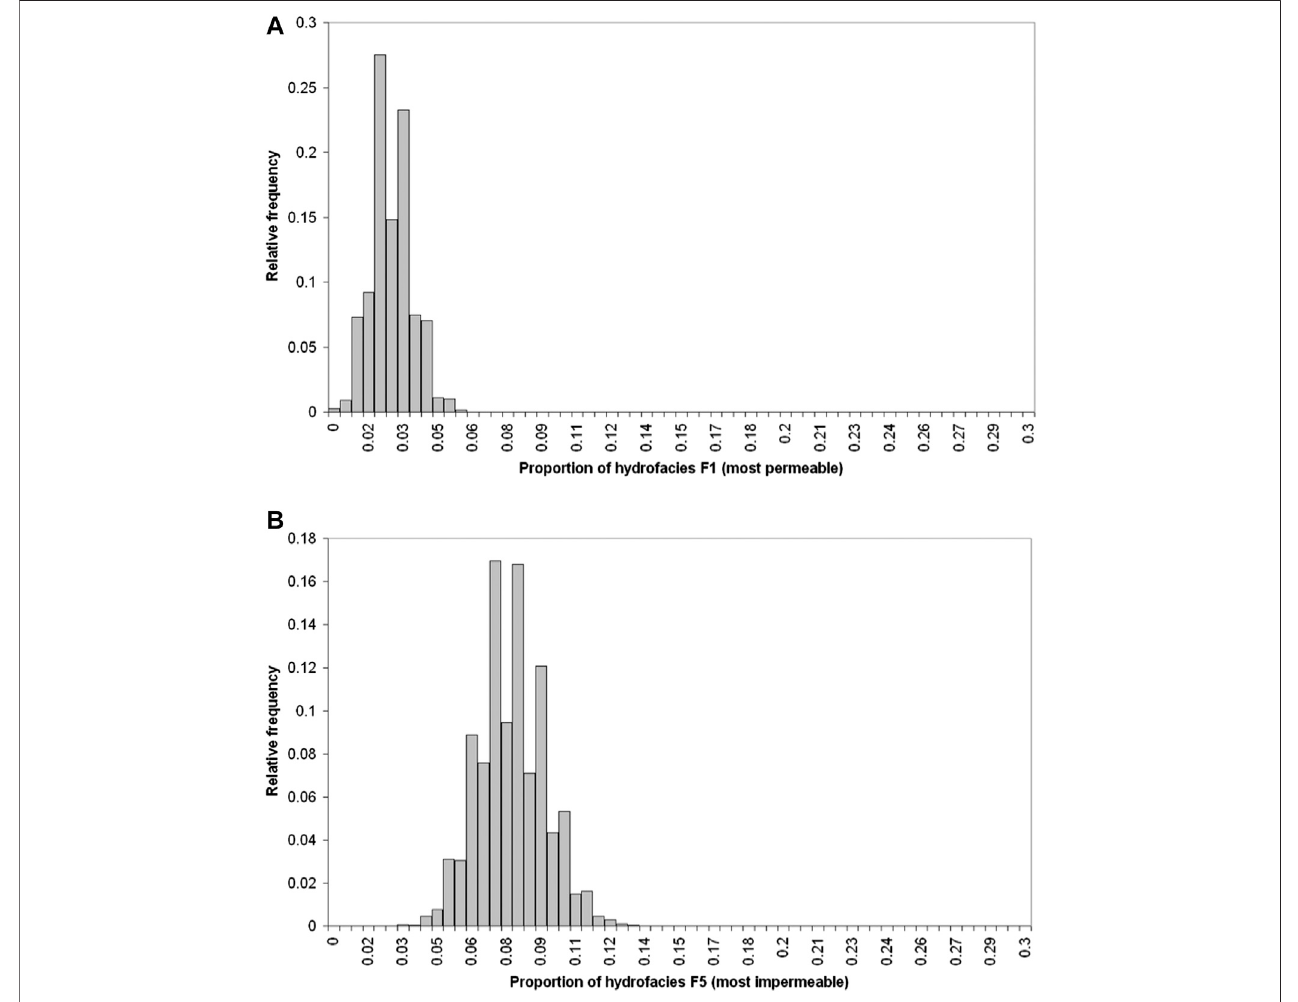
FIGURE 4 | Histogram of the bootstrap distribution for (A) F1 hydrofacies and (B) F5 hydrofacies.